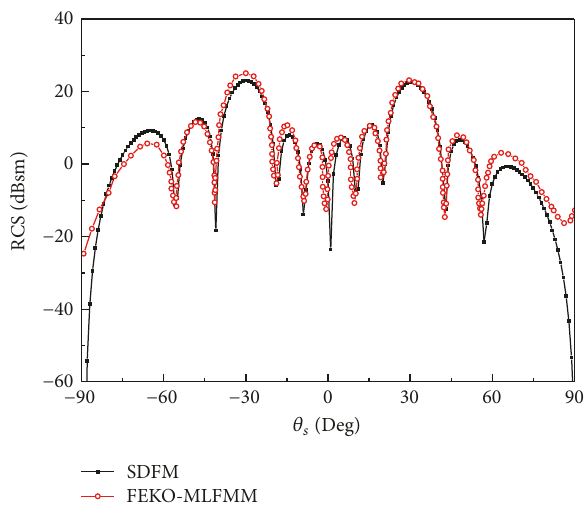
Figure 5: Bistatic RCS results for the facet (VV-polarization). Table 1: Runtime performances of different